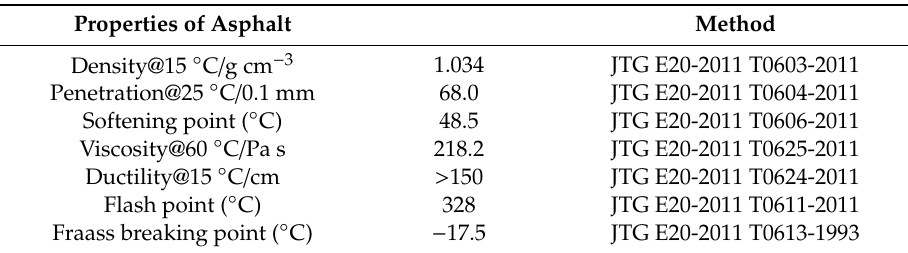
Table 2. Physical properties of 70#